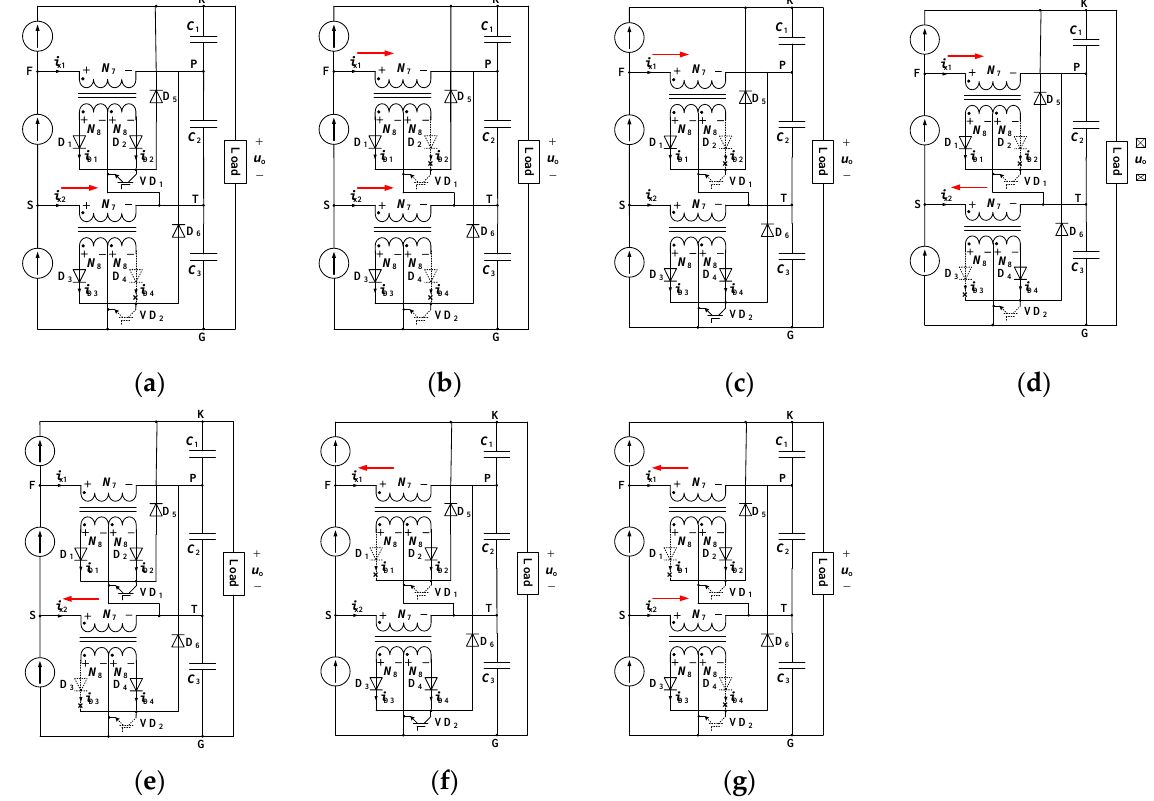
Figure 6. Operating modes of the harmonic injection circuit. ( a ) Mode. 1. ( b ) Mode. 2. ( c ) Mode. 3. ( d ) Mode. 4. ( e ) Mode. 5. ( f ) Mode. 6. ( g ) Mode. 7. The red arrows represents the directions of cur- rents i x1 and i x2 .